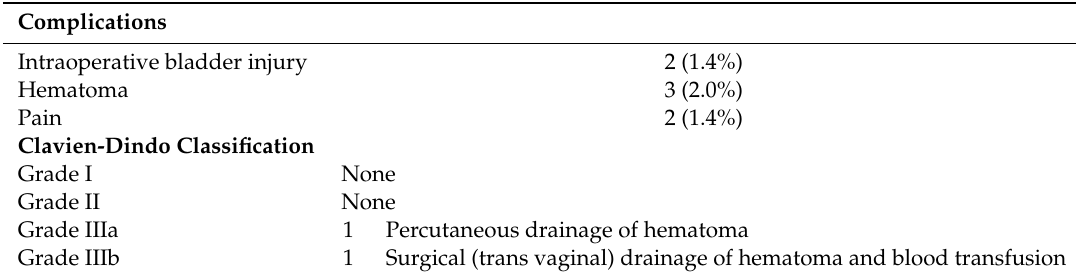
Table 5. List of complications and Clavien–Dindo